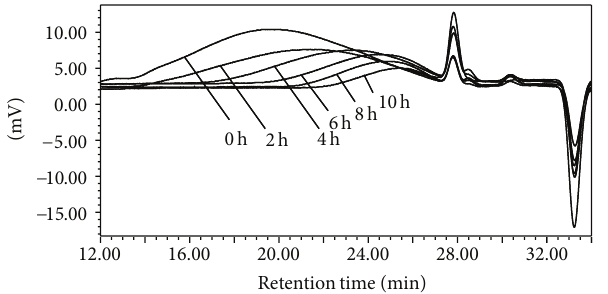
Figure 2: Chromatographic profiles obtained by GPC for control chitosan without thermal treatment (0 hour) and chitosans treated for up to 10 h.